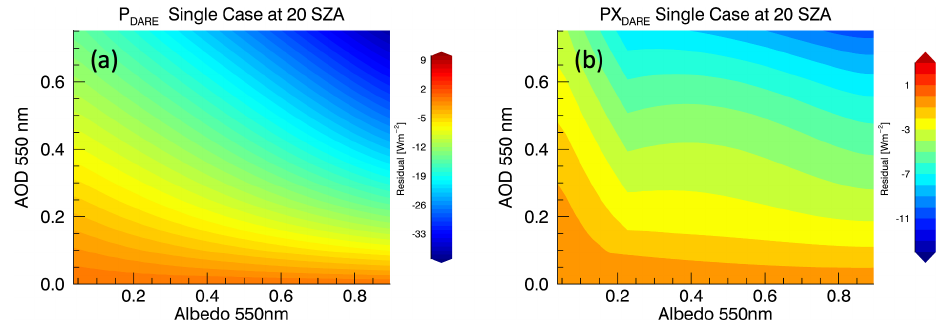
Figure 11. Residual plot of directly calculated DARE (RTM output) and predicted BB DARE values using (a) P DARE and (b) PX DARE for a single case at a fixed SZA (20 ◦ ). Residual plots for each case can be found in Appendix D. For both figures, the residuals encompass the difference between the RTM and the P DARE and PX DARE